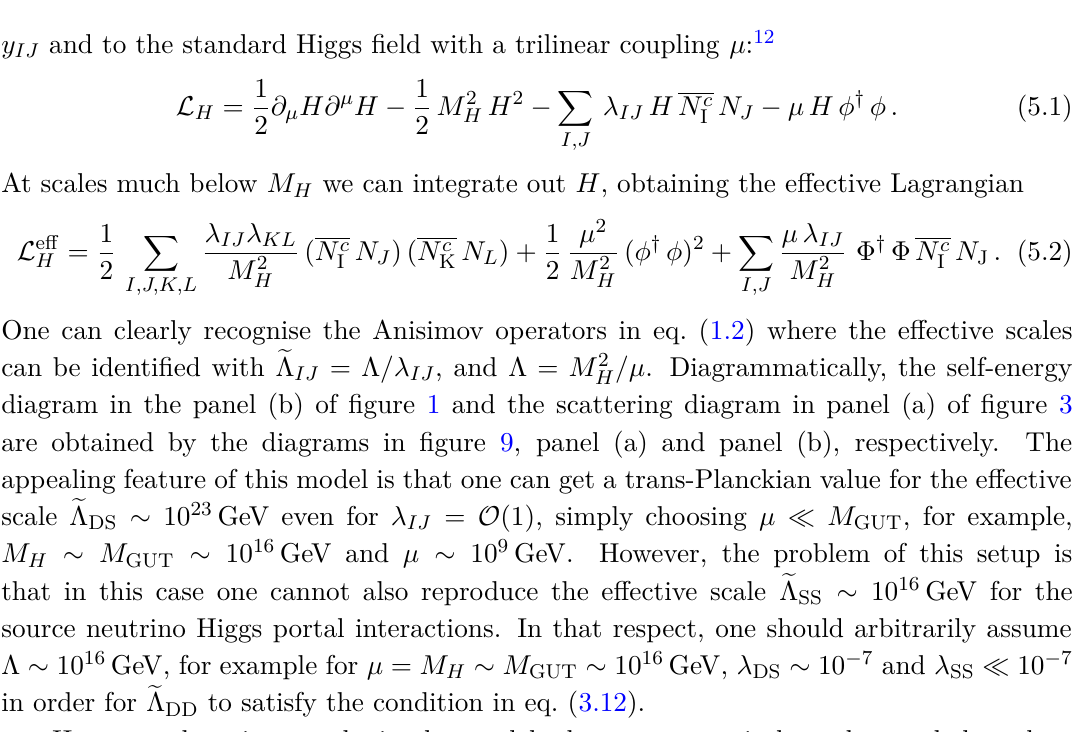
Figure 9 . Feynman diagrams with a heavy scalar H as mediator and I, J = D , S . Integrating out H , they lead to the Feynman diagrams in panel (b) of figure 2 and (a), (b) and (c) of figure